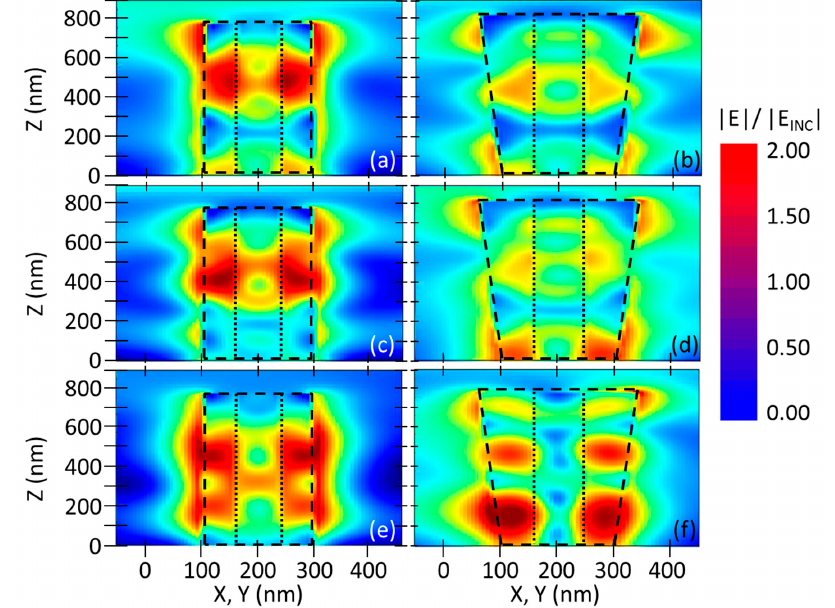
Figure 5. Longitudinal electric field intensity distribution around a NW with respect to the angle of incidence θ . Near-field normalized electric field expansion for the nontapered C–S geometry, ( a ) at an incident angle θ = 0° and a wavelength of 925 nm; ( c ) at an incident angle θ = 40° and a wavelength of 800 nm and ( e ) at an incident angle θ = 70° and a wavelength of 735 nm. Near-field normalized electric field expansion for the tapered C–S geometry, ( b ) at an incident angle of θ = 0° and a wavelength of 925 nm, ( d ) at an incident angle of θ = 40° and a wavelength of 820 nm and ( f ) at an incident angle θ = 70° and a wavelength of 690 nm.